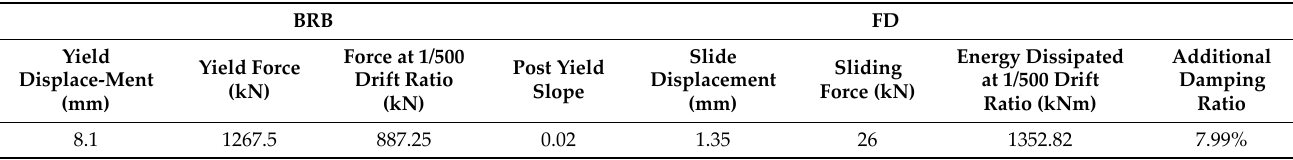
Table 4. Primary mechanical parameters for FBRB.